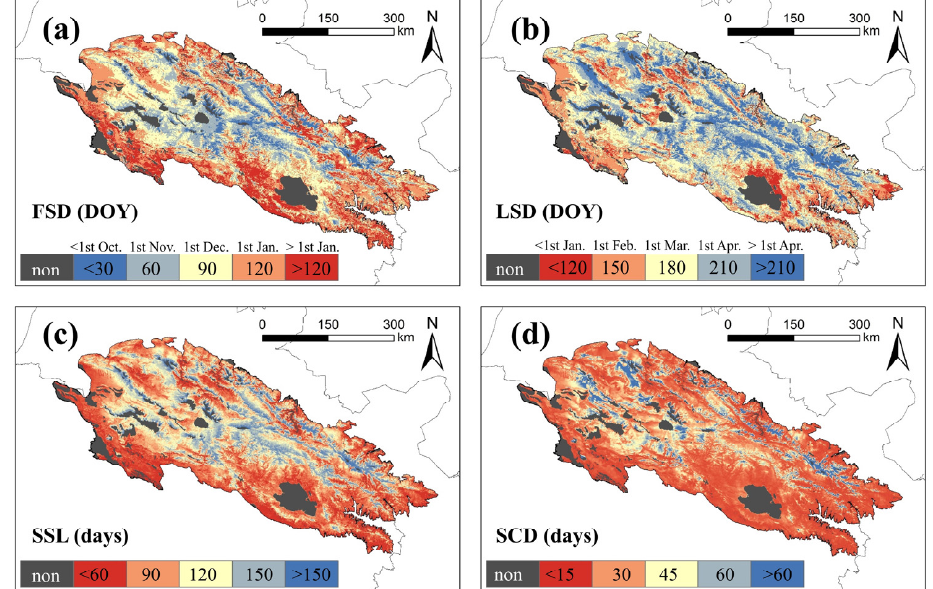
Figure 5. Mean of snow seasonality metrics in QLMA from 2002 to 2020. ( a ) represents the FSD, ( b ) ( b ) represents the LSD, ( c ) represents the SSL, and ( d ) represents the represents the LSD, ( c ) represents the SSL, and ( d ) represents the SCD.